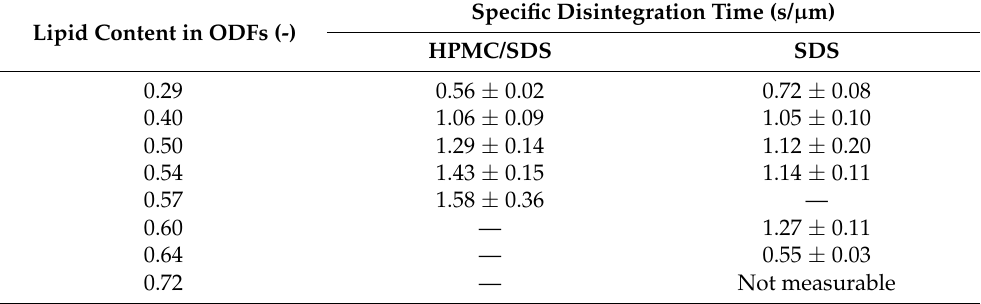
Table 1. Influence of lipid content and particle formulation (HPMC/SDS and SDS) on the specific disintegration time, n =